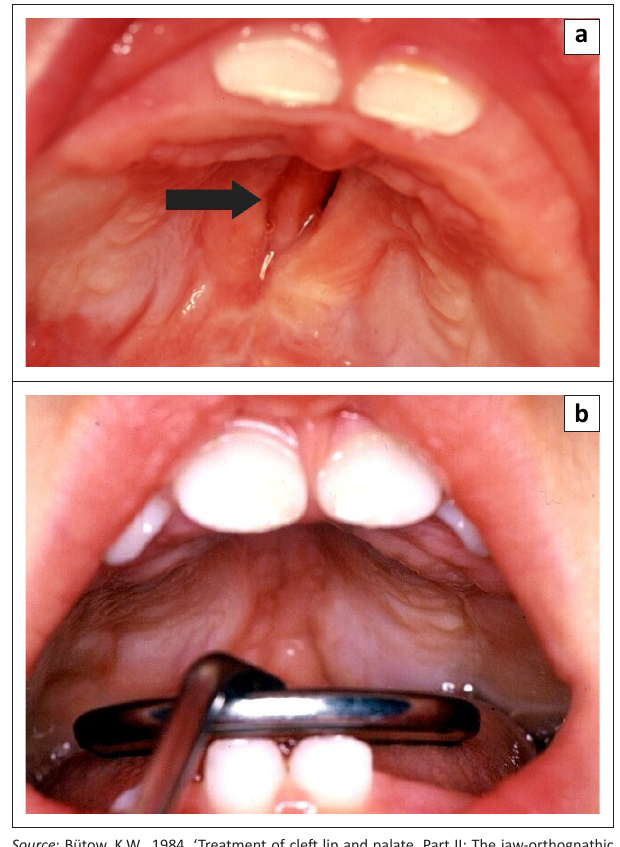
FIGURE 4: (a) Post-operative appearances of the soft palate and narrowing of hard palate cleft after 18 months, before the closure of the hard palate cleft. (b) Post- operative appearances after